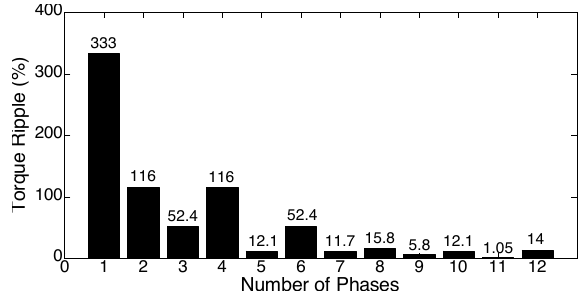
Figure 10: Percentages of electromagnetic torque ripples for a few Claw Pole TFPM motors with different phase